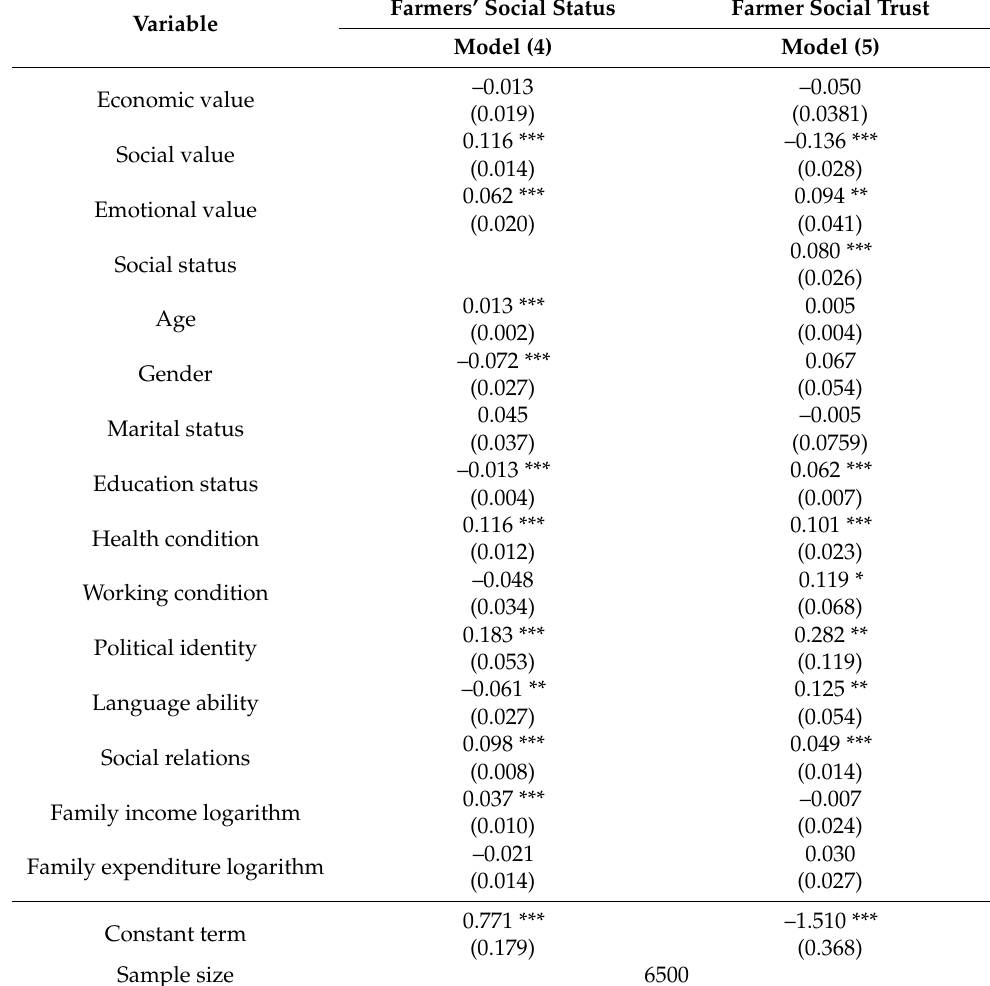
Table 4. Mediating effect model regression results of farmers’ children’s value influencing social